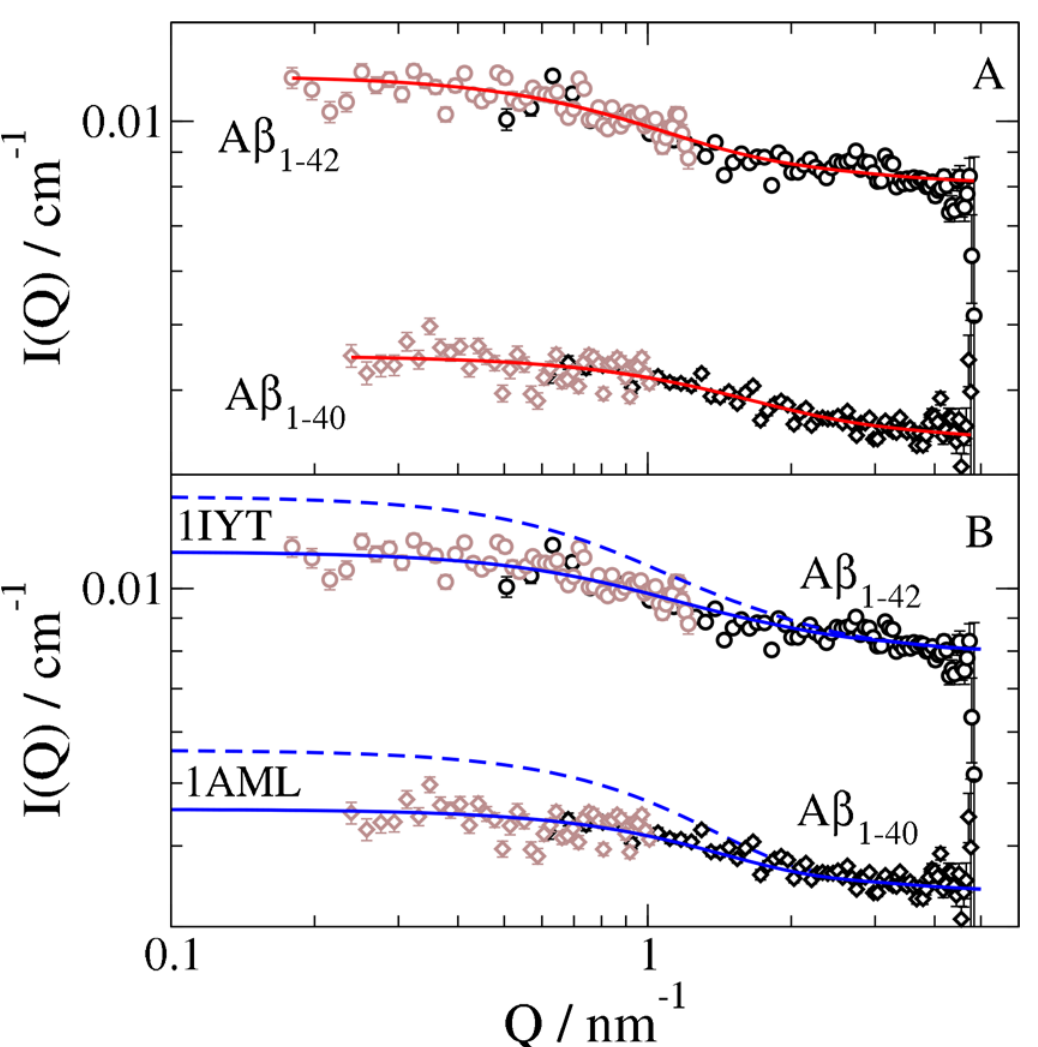
Fig 2. Scattering intensity of A β monomers in dHFIP (Aß 1-42 , concentration 5.6 mg/ml, Aß 1-40 concentration 2.4 mg/ml) after three weeks incubation measured at detector distance of 5.6 m (grey) and 1.1 m (black). (A) The red solid line shows the fitted Beaucage function with fixed dimensionality d = 2 . (B) SANS data compared to simulations based on atomic coordinates from 3D NMR structure data (Aß 1-42 PDB code 1IYT, A β 1 – 40 compared to PDB code 1AML). Broken blue lines represent the average over the PDB structures; while solid blue lines include a surface layer with increased solvent